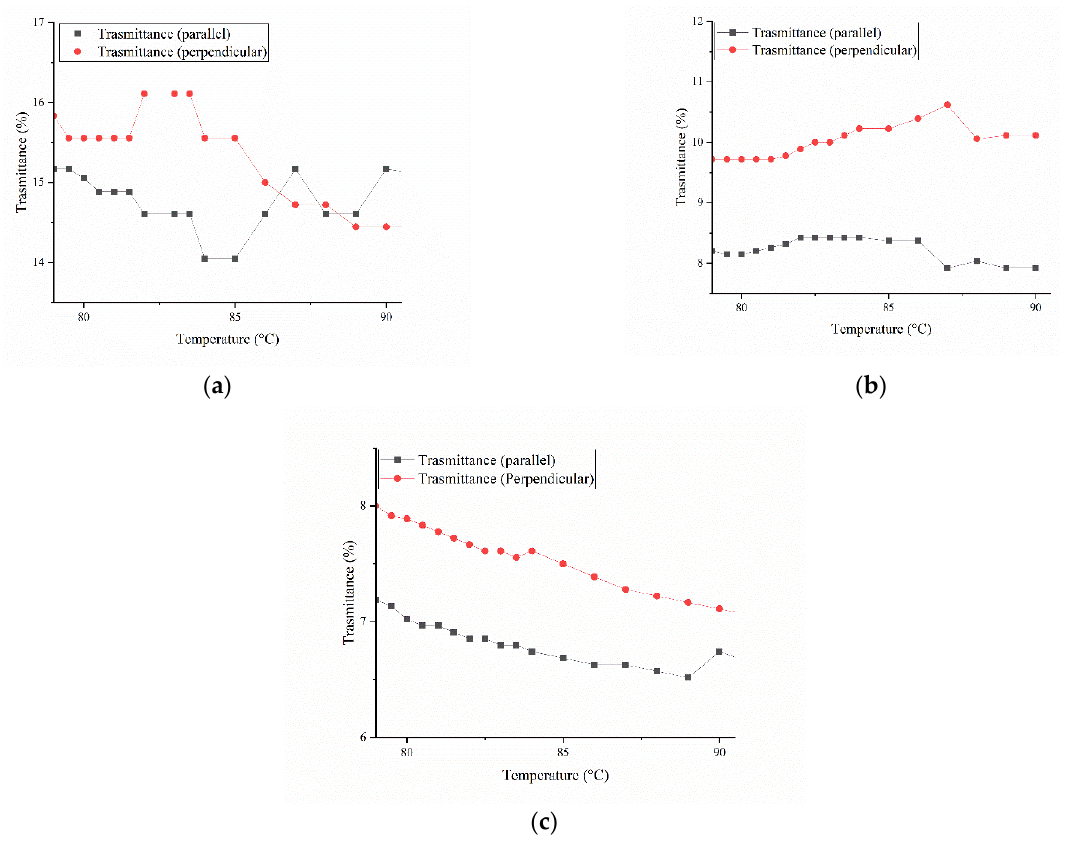
Figure 3. ( a ) Transmittance measurement of LC81. ( b ) Transmittance measurement of LC18. ( c ) Transmittance measurement of LC11.